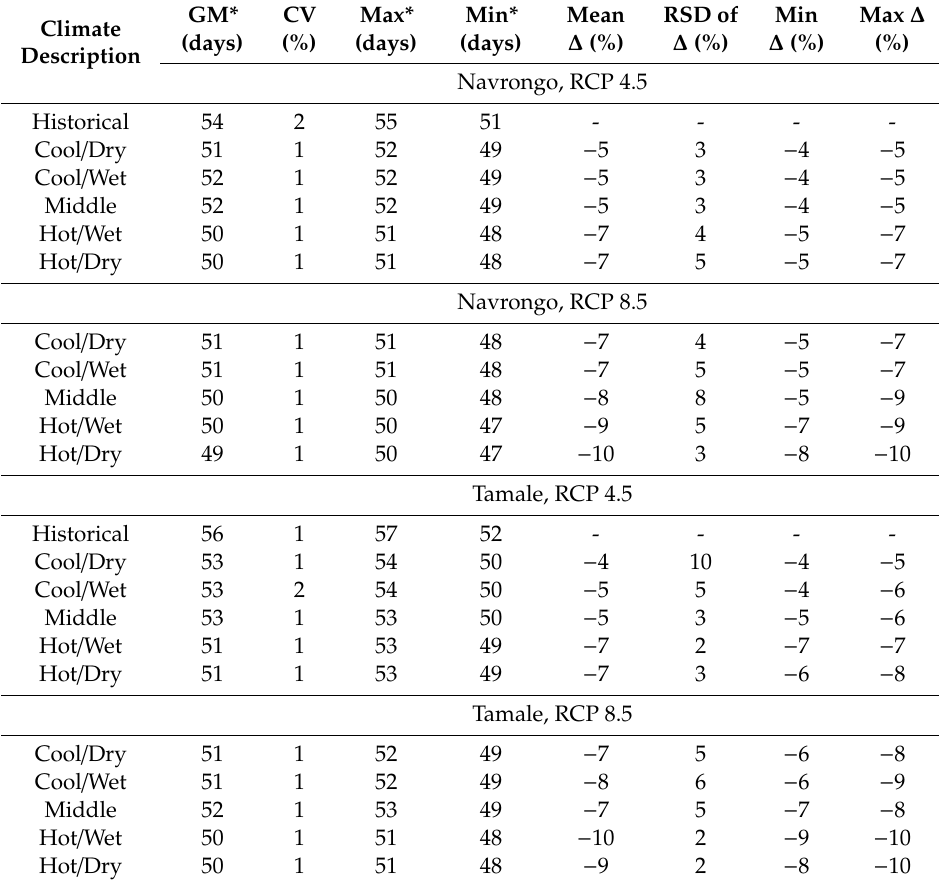
Table A2. Impact of climate change scenarios on days to maturity at three sites in semi-arid region of West Africa.